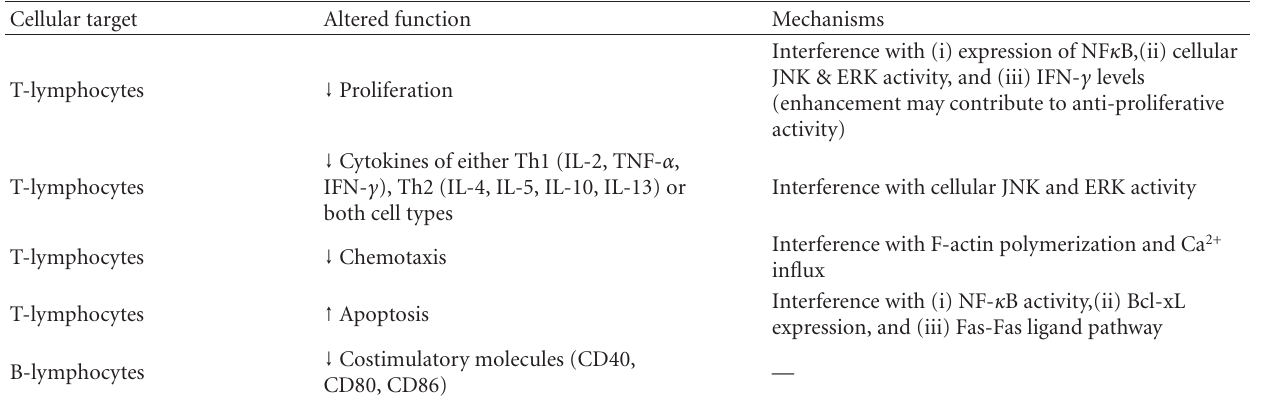
Table 3: The anti-inflammatory e ff ects of macrolides on T- and